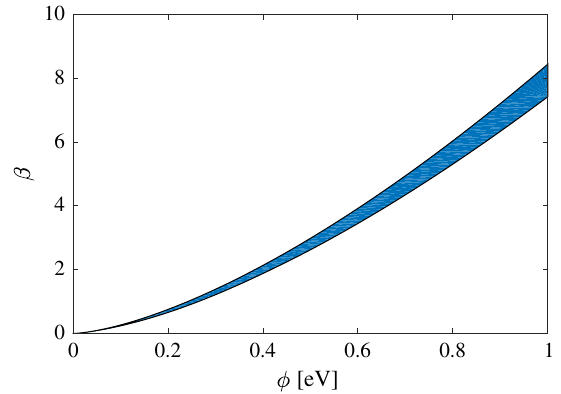
FIG. 12. β as a function ofworkfunction ϕ using thevalues of E c from table I. Each point in the blue region on the plot represents a possible combination of field enhancement factor and local work function which match the data with a 95% confidence